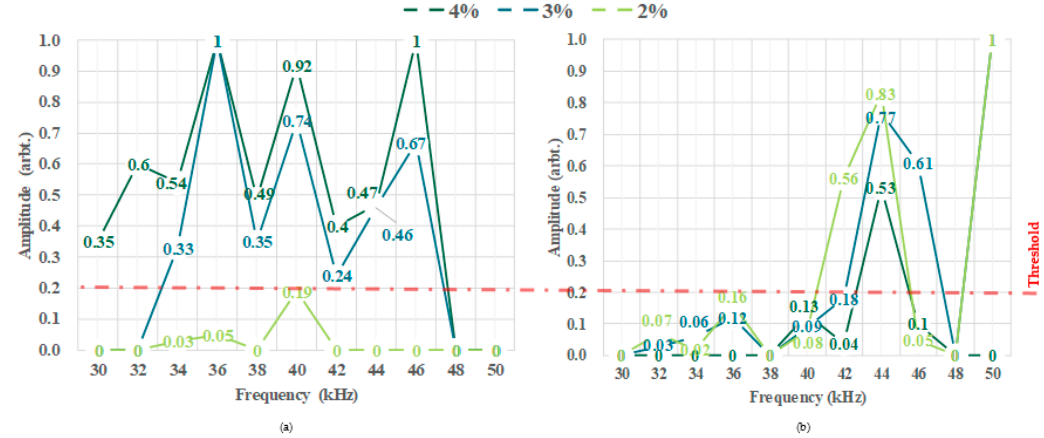
Figure 18. Results achieved using the algorithm where ( a ) shows the detection amplitude of defect signal and ( b ) shows the detection amplitude of the outlier. Each line represents a defect with different CSA size. The red dotted line represents the amplitude threshold for filtering the outliers.